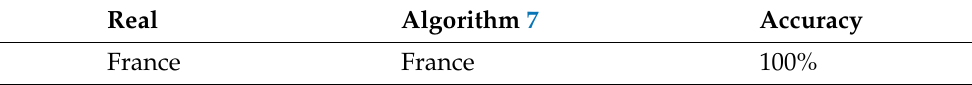
Table 18. Champion. Real Algorithm 7 Accuracy